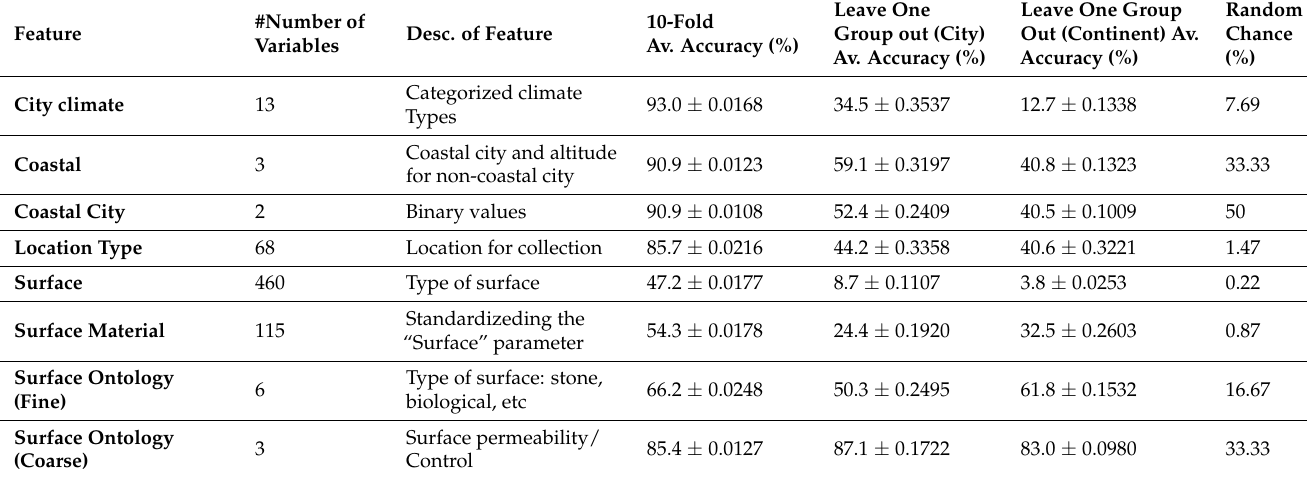
Table 3. Cross-validation methods for data interpolation: For 8 features, we perform cross-validation based on 10-fold and leave-one-group-out split based on cities/continent as groups. The table explains the features and reports the average accuracy and standard deviation for the different splits for the best method among the above 3 mentioned. In general, we find the accuracy for predicting a feature from an unknown city higher than that from an unknown